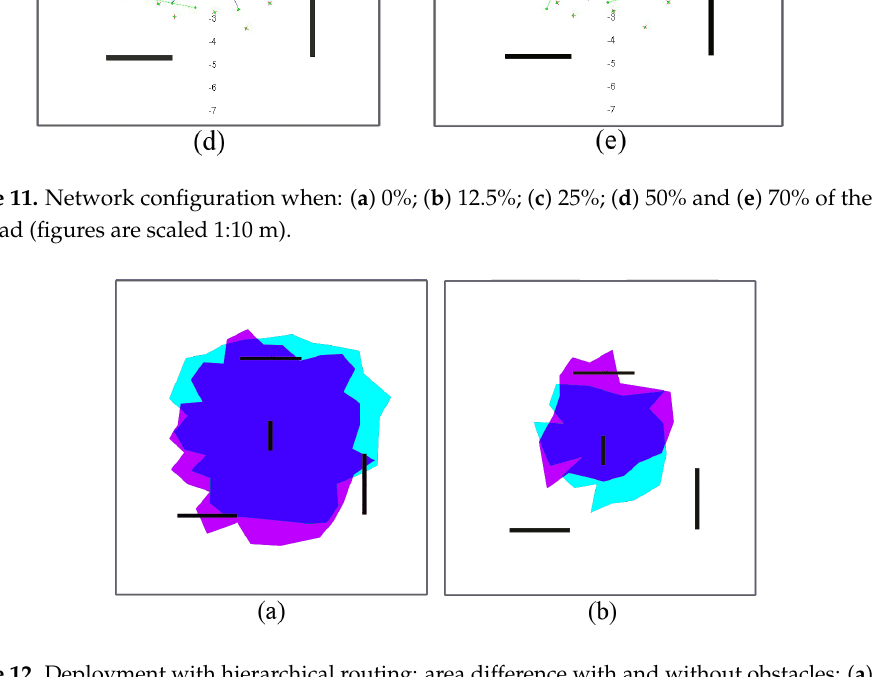
Figure 12. Deployment with hierarchical routing: area difference with and without obstacles: ( a ) initial; ( b )